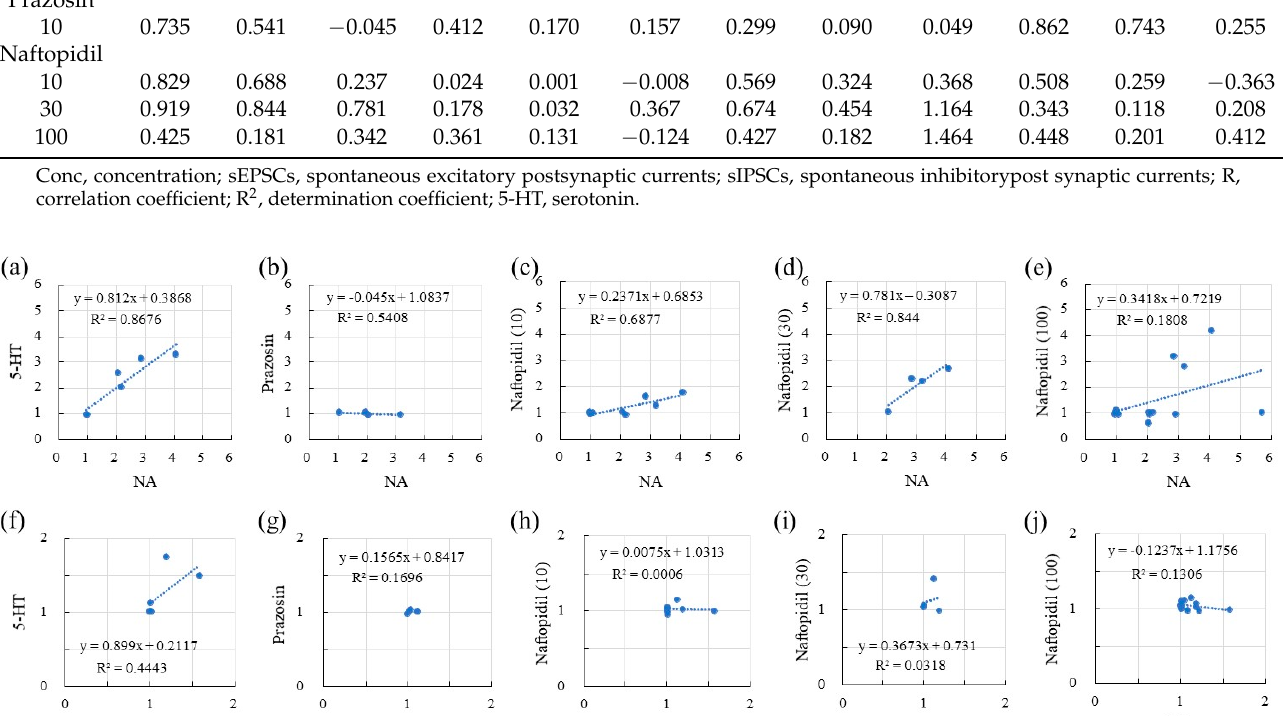
Figure 2. The association between NA (50 μ M) and each ligand in terms of the response ratios of Table 1. HT (50 μ M) ( a ), prazosin (10 μ M) ( b ), and naftopidil (10, 30, and 100 μ M) ( c – e , respectively). Similarly, for amplitude, the associations with NA of 5-HT (50 μ M) ( f ), prazosin (10 μ M) ( g ), and naftopidil (s10, 30, and 100 μ M) ( h – j , respectively) are presented. The x and y axes reveal the ratio of frequency or amplitude of sIPSCs after adding the drugs (NA, 5-HT, prazosin, or naftopidil) to before the adding in the single SG neuron.